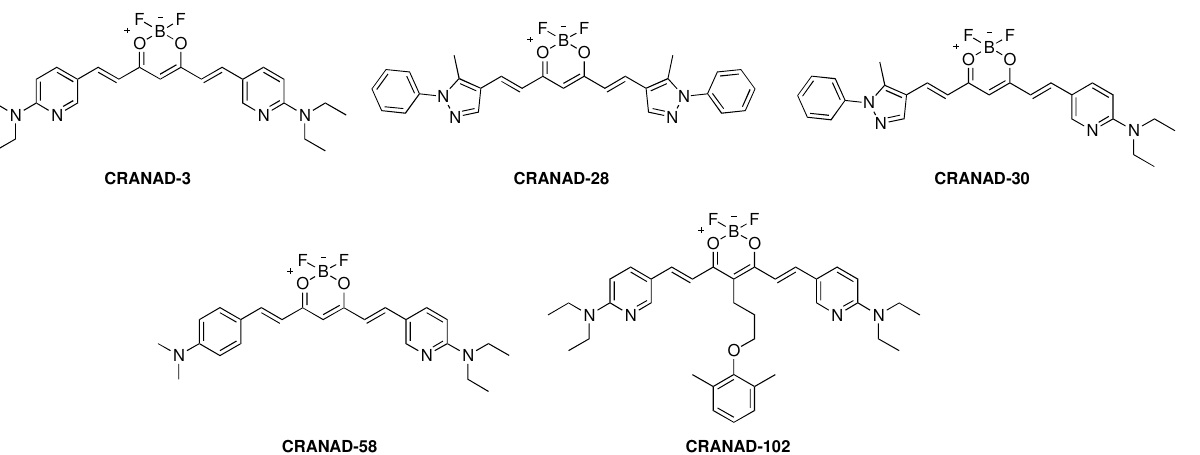
high-efficiency diagnosis method in AD research due to the eye’s minimal opacity.